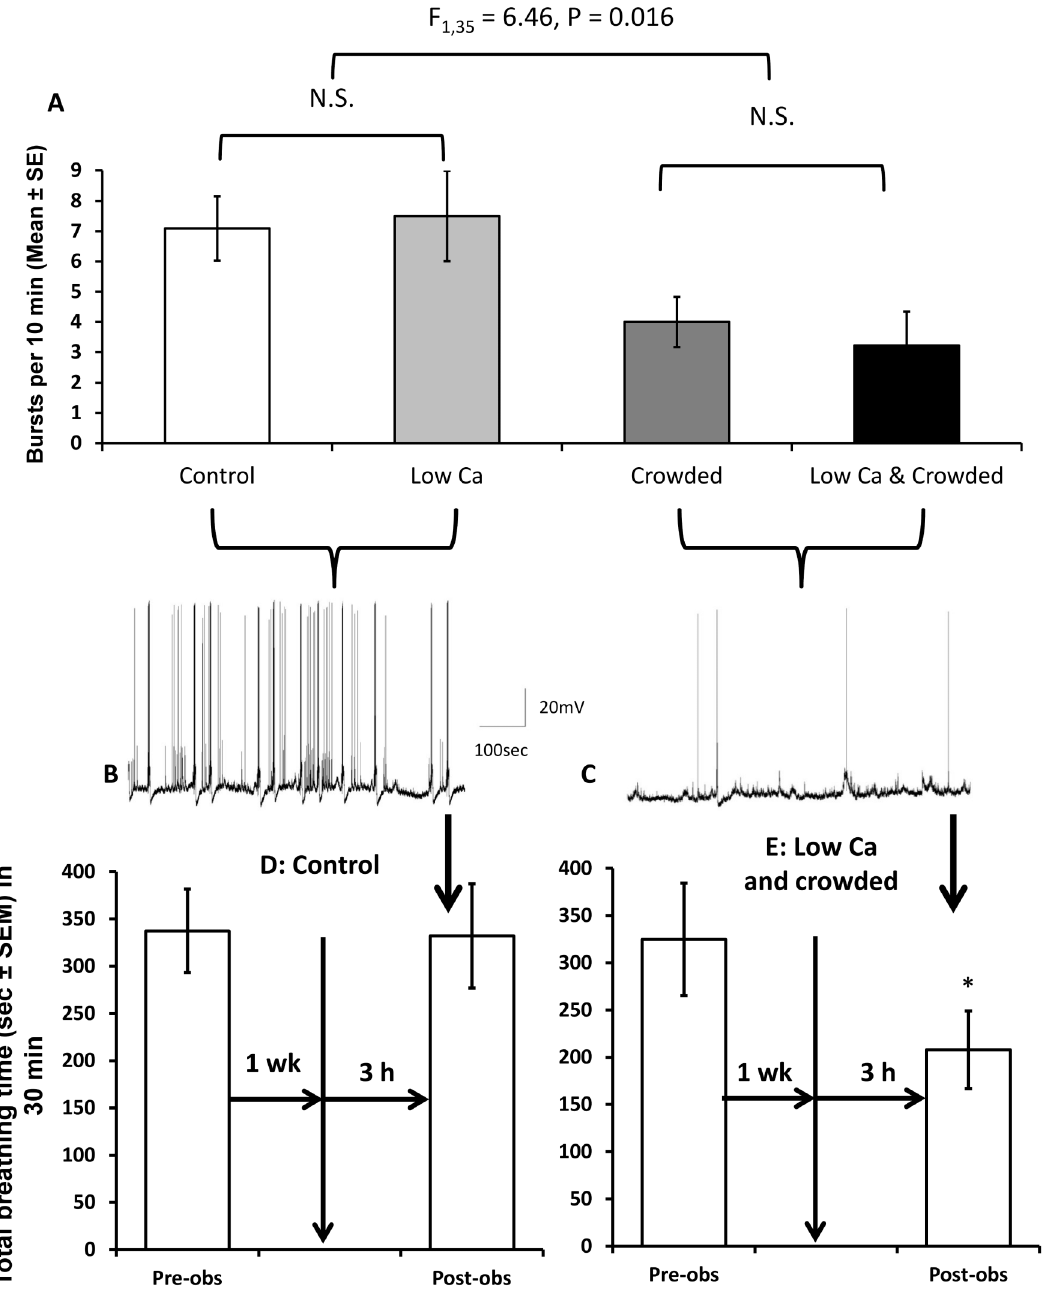
Figure 1. Burst activity in RPeD1 and breathing behaviour 3 h post-stress exposure. RPeD1 burst activity in naı¨ve Lymnaea . A) Mean ( 6 SEM) burst activity in untrained Lymnaea following exposure to control conditions (white bars: N=11), low calcium availability (pale grey bars: N=10), crowding (dark grey bars: N=9) or a combination of low calcium availability and crowded conditions (black bars: N=9). Representative traces show burst activity in RPeD1 over 10 min in naı¨ve Lymnaea exposed to B) control conditions, which did not differ significantly from those exposed to low calcium only; and C) combined stressors, which did not differ significantly from those exposed to crowding only. Breathing activity in untrained Lymnaea 1 week prior to exposure (pre-obs) and 3 h following exposure (post-obs) to D) control conditions (N=12) or E) combined stressors (N=12). Control animals did not alter their breathing rate, whereas combined stressors significantly depressed aerial breathing behaviour.